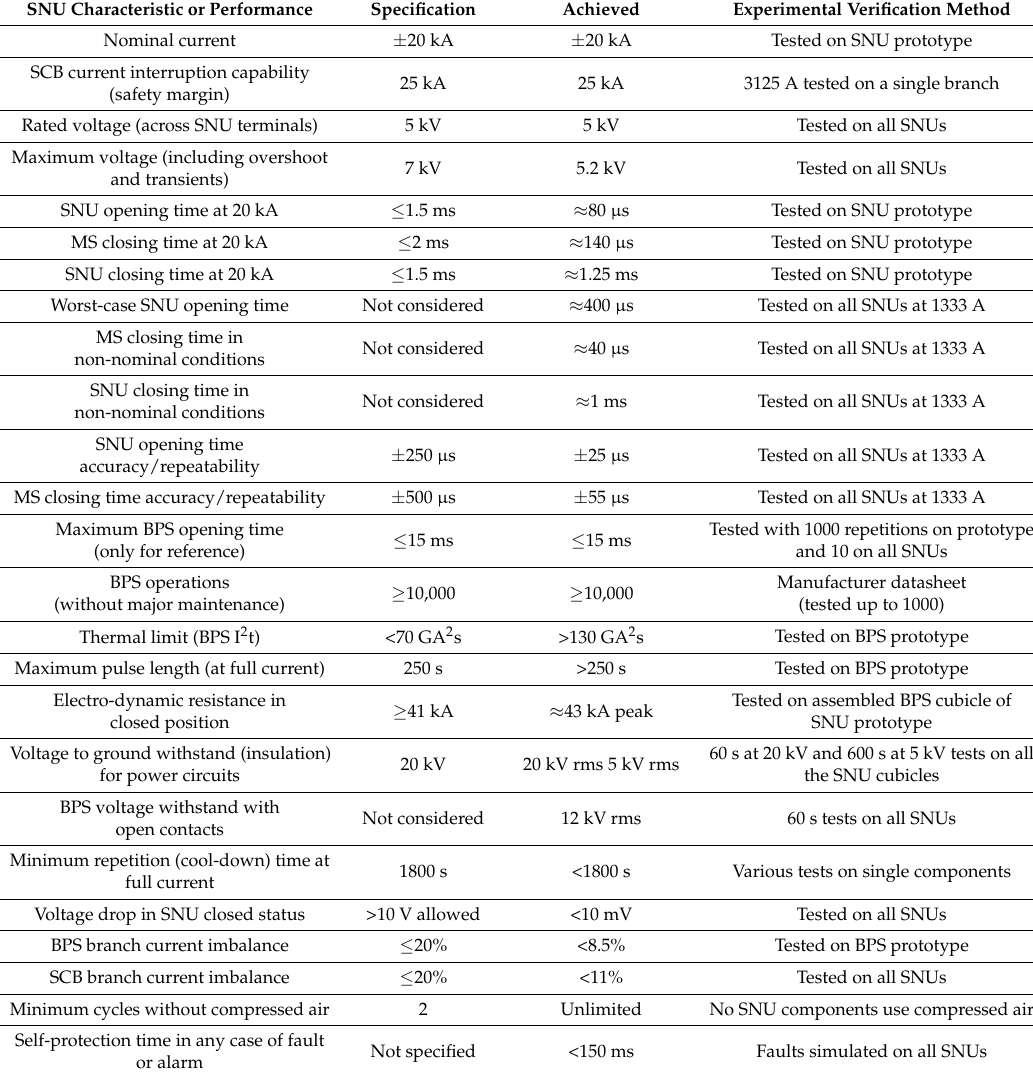
Table 1. SNU characteristics as requested in specifications and as obtained in the realized SNUs with references to the method used to experimentally verify that